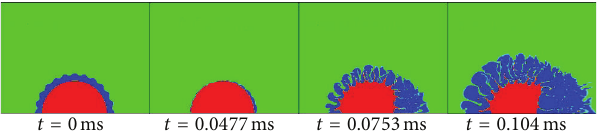
Figure 9: Evolution of a droplet with an unstable vapor film ( 𝜌 𝑑 = 3000 kg/m 3 ).